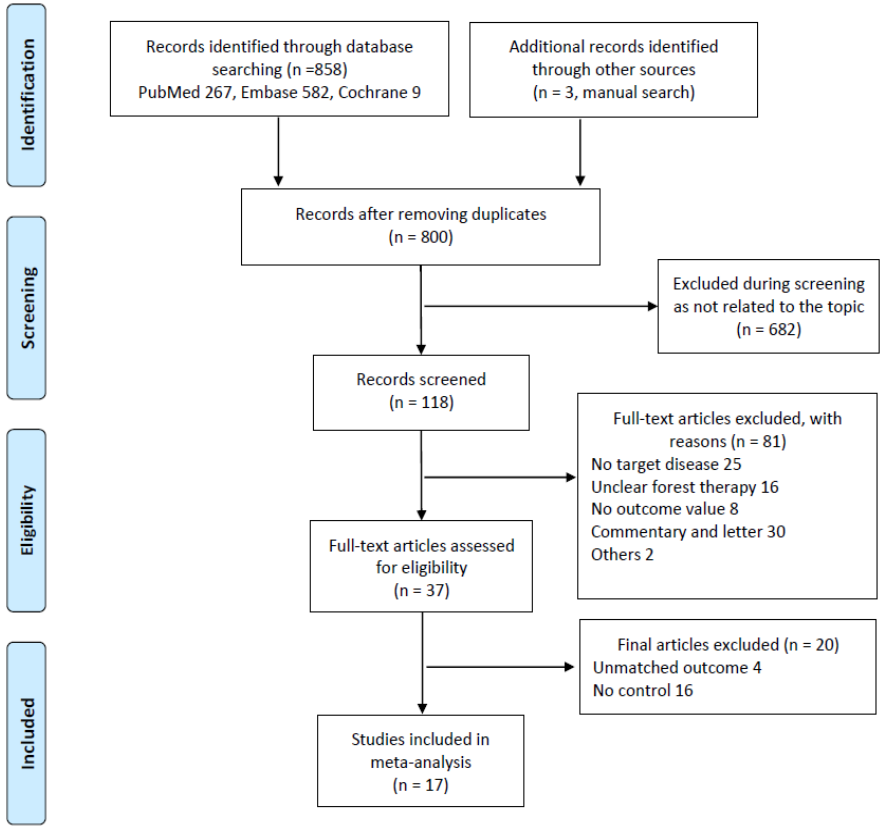
Figure 1. PRISMA flow diagram of the search strategy and study selection. PRISMA, preferred reporting items for systematic reviews and meta-analyses.